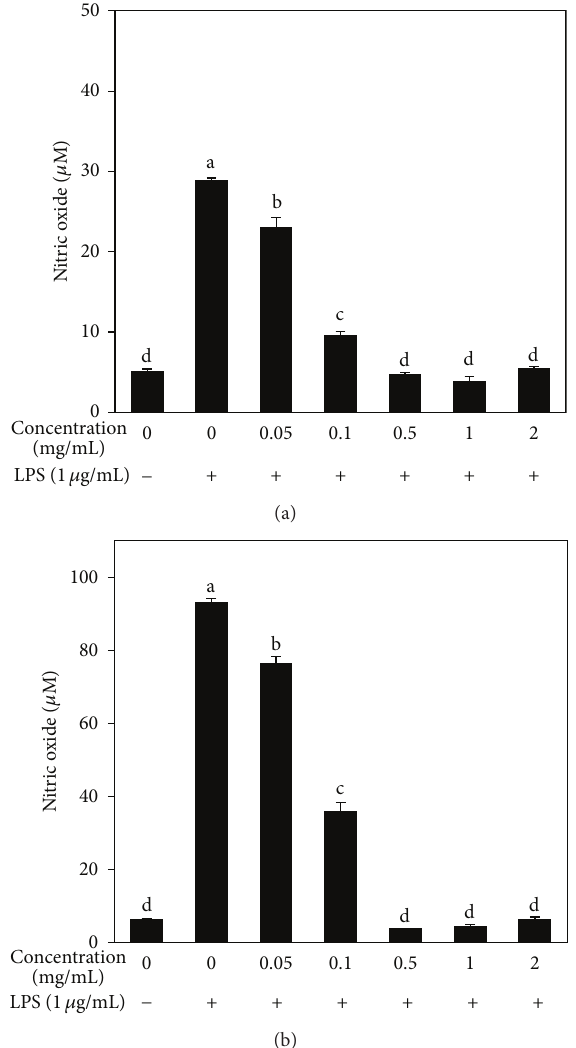
Figure 2: Effect of AM on intracellular NO level in LPS-stimulated RAW 264.7 cells. The cells were pretreated with LPS (1 𝜇 g/mL) and followed by treatment with the AM for 24 h (a) and 48 h (b). The nitrite content of culture media was analyzed. a–d Mean with the different letters is significantly different ( 𝑃 < 0.05 ) by Duncan’s multiple range